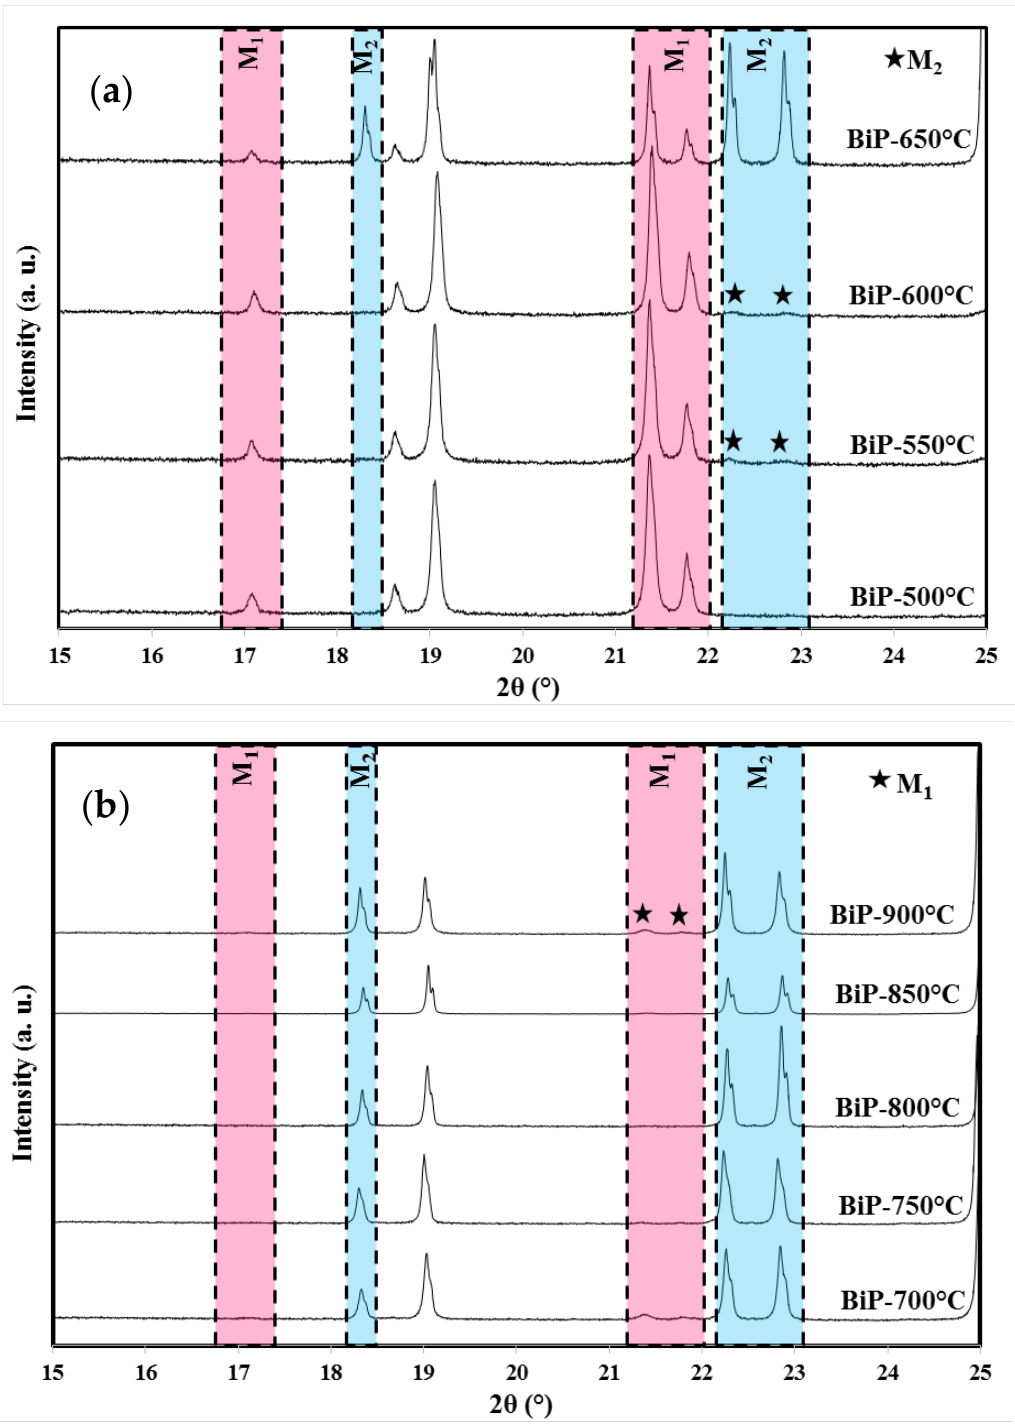
Figure 2. XRD diffraction profiles in the angular range 15° to 25° 2 θ of the BiP -Θ samples: the disappearance of the Kα 1 – α 2 doublet of the Bragg peaks for the monoclinic phase M 1 from BiP-700 °C, appearance of the Bragg peaks from BiP-550 °C of the monoclinic phase M 2 . ( a ) 500, 550, 600 and 650 °C, ( b ) 700, 750, 800, 850 and 900 °C. Table 2. The transformed mole fraction of M 1 and M 2 samples sintered at various temperatures.